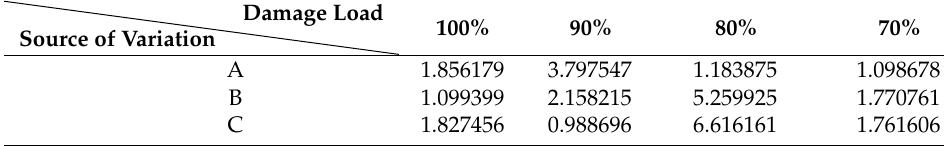
Table 9. F -values of the strength recovery rate after healing at aging for 7